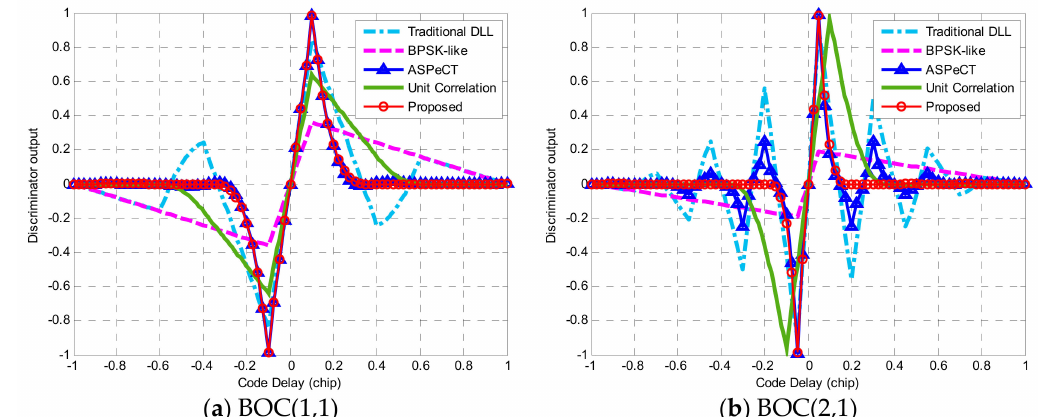
Figure 18. The phase discrimination curve.